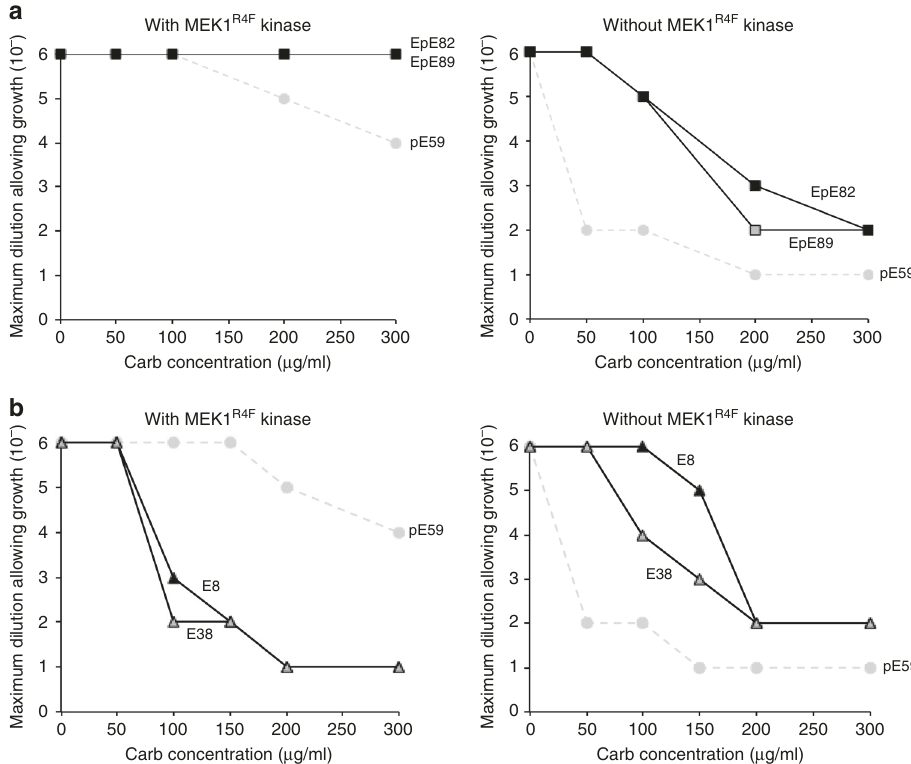
Fig. 3 Phenotypic selection of DARPins binding cognate antigens. Survival curves for serially diluted E. coli MC4100 cells co-expressing TatABC along with ERK2-Bla and either: a Tat-targeted DARPins EpE82 (black squares) and EpE89 (gray squares) that recognize both ERK2 forms; or b Tat-targeted DARPins E8 (black triangles) and E38 (gray triangles) that speci fi cally recognize nonphosphorylated ERK2. Resistance of cells was evaluated in the presence (left) or absence (right) of MEK1 R4F kinase as indicated. Overnight cultures were serially diluted in liquid LB and plated on LB agar supplemented with Carb. Maximal cell dilution that allowed growth is plotted versus Carb concentration. Resistance pro fi les for pERK2-speci fi c DARPin pE59 are shown (gray circles) for comparison. Source data for this fi gure is available in the Source Data